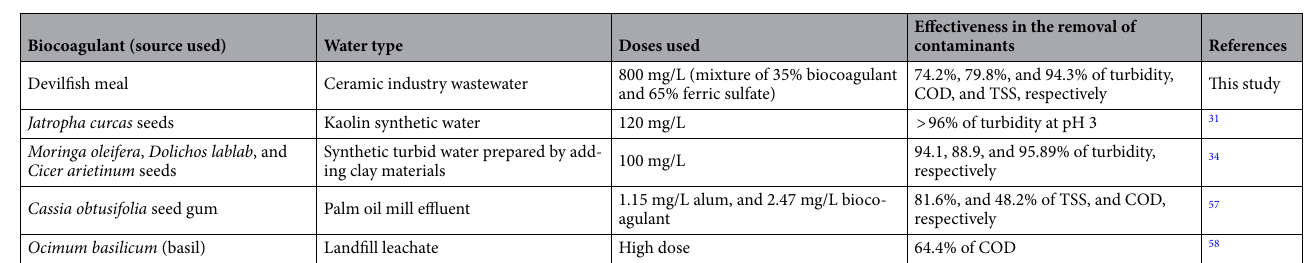
Table 5. Comparison of the effectiveness in water and wastewater treatment using